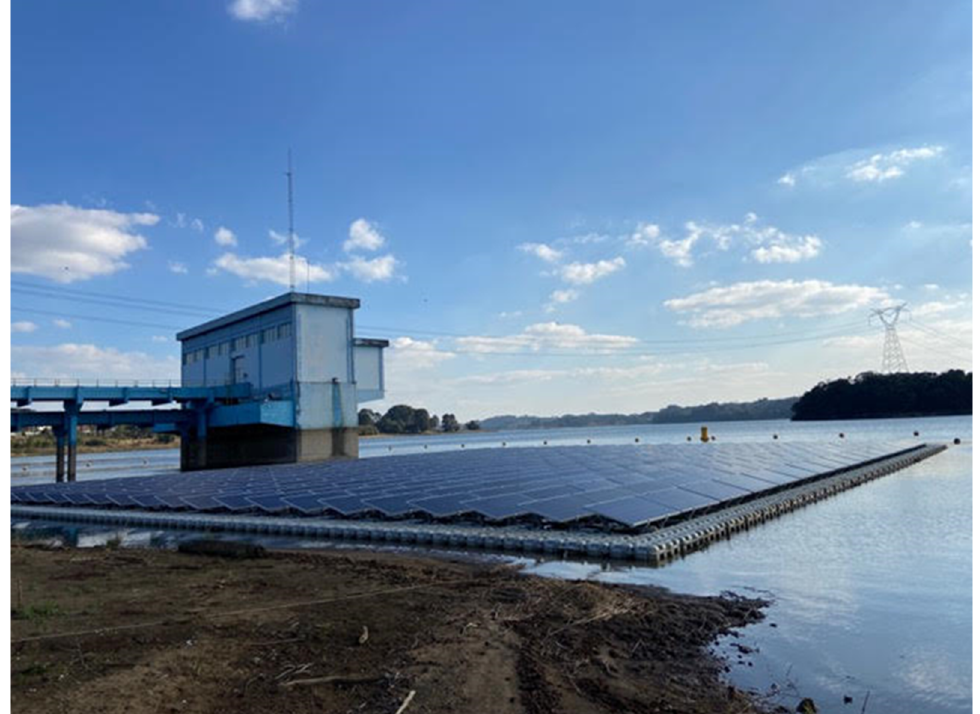
Figure 2. FPS in the Passaúna Reservoir.